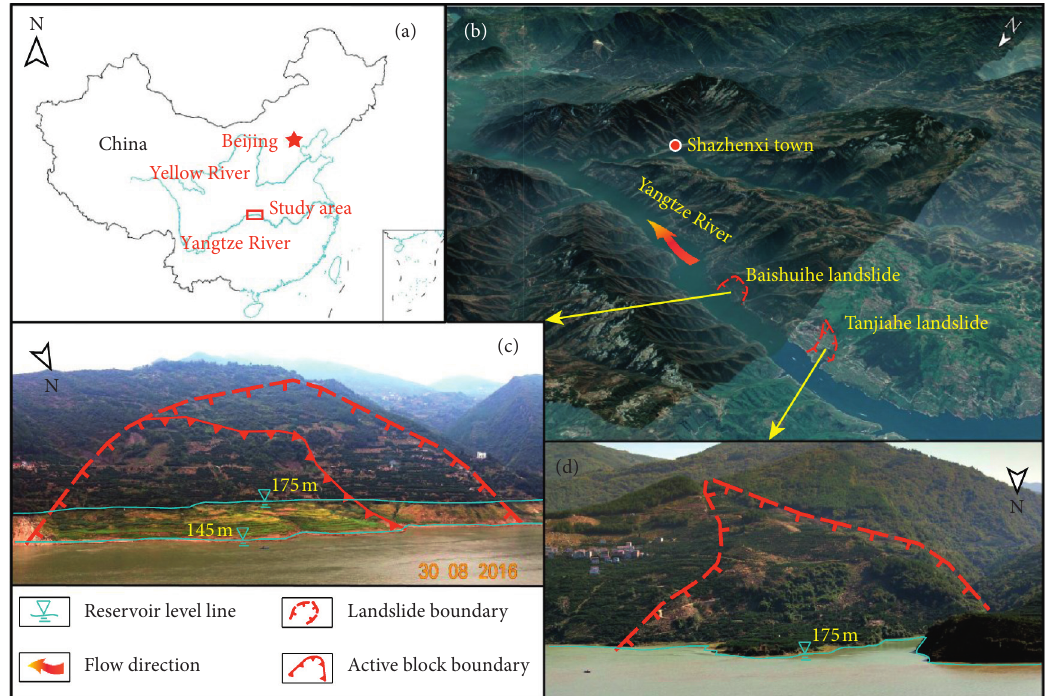
Figure 1: (a) Location of the study area, Three Gorges Reservoir area, China. (b) Location of the Baishuihe and Tanjiahe landslides. (c) Overall view of the Baishuihe landslide. (d) Overall view of the Tanjiahe